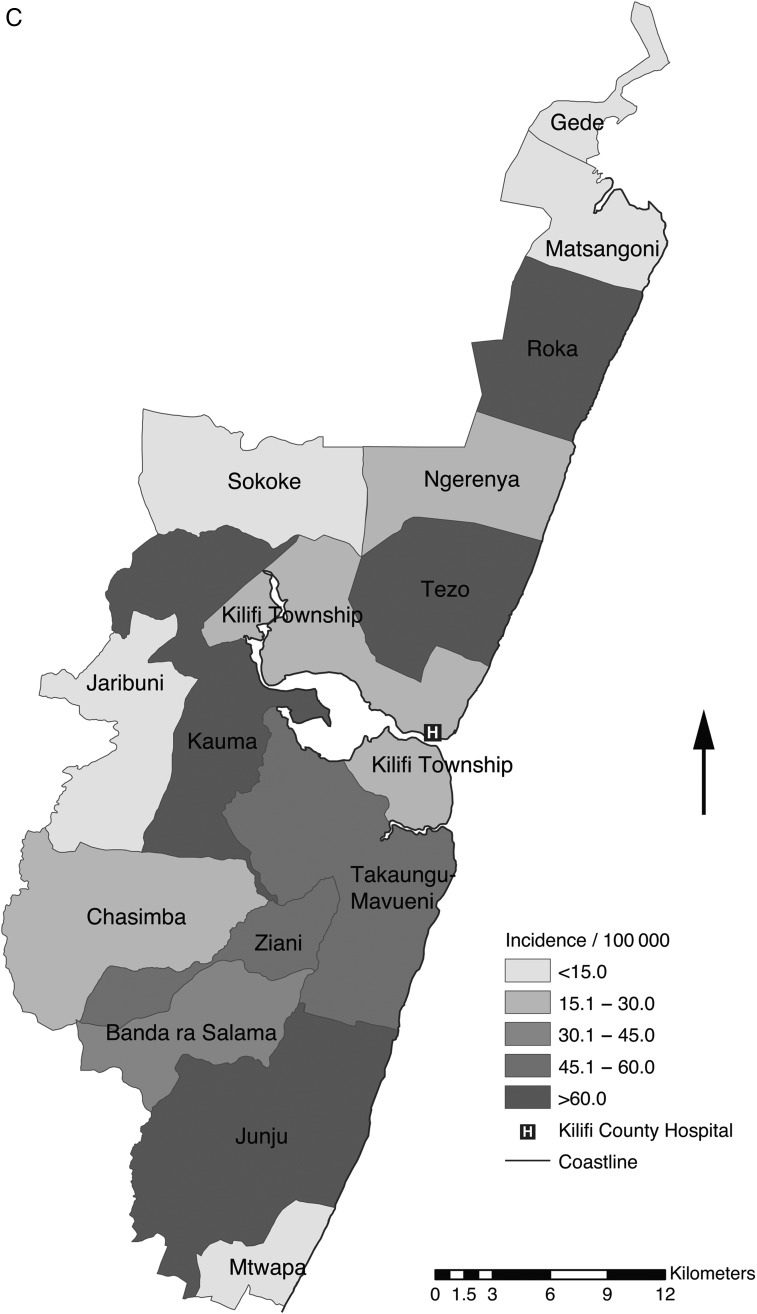
Figure 2 continued. C, Map of the Kilifi Health and Demographic Surveillance System showing geographical distribution of the access-adjusted rates of NTS bacteremia among children aged <5 years. Abbreviation: PYO, person-years of observation.